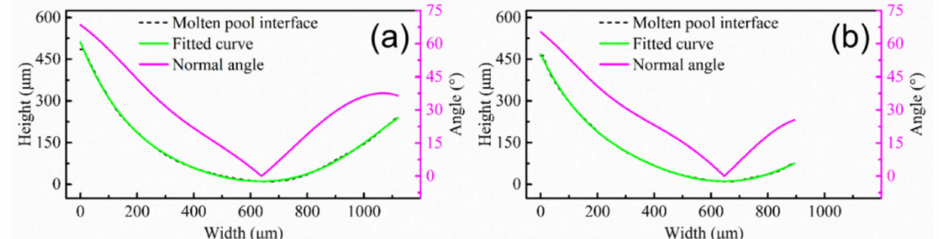
Figure 13. Molten pool interface and normal angle with different track offset: ( a ) 1 mm; ( b ) 0.6